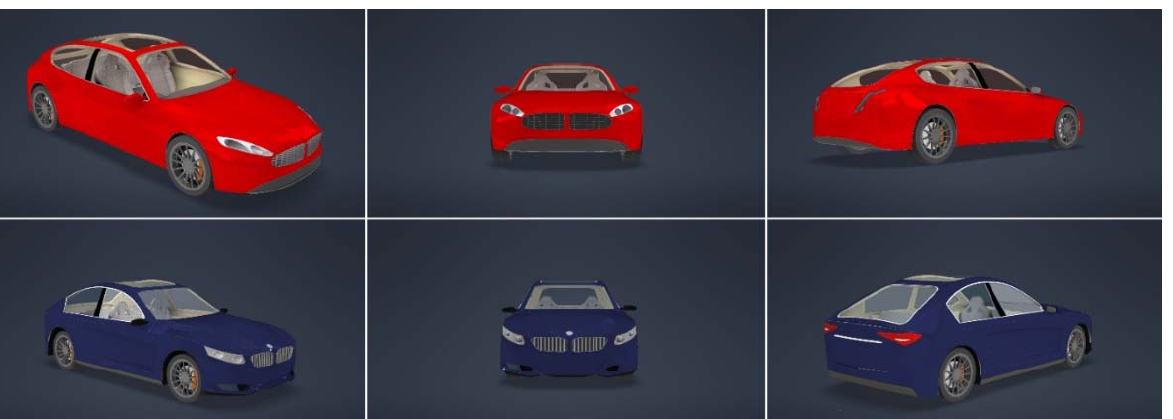
Figure 18. Pressure contour and streamlines around the vehicle.